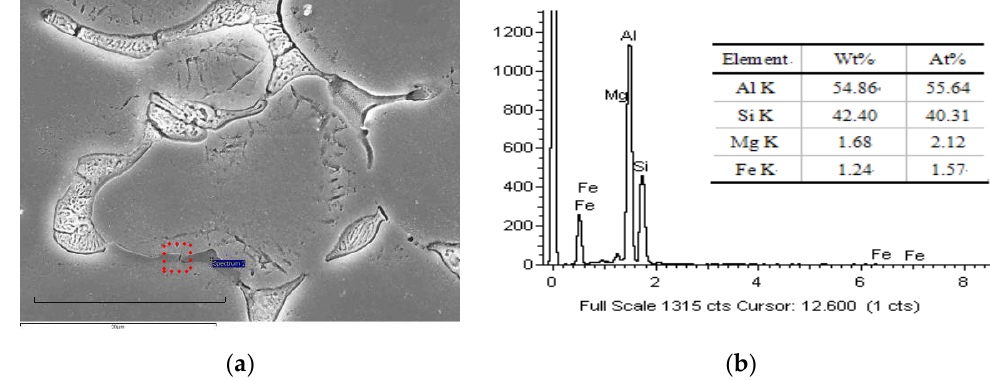
Figure 11. Element distribution at the grain boundary: ( a ) natural cracking surface, ( b ) elemental distribution